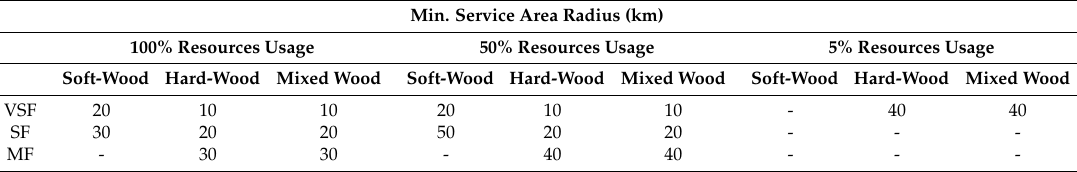
Table 7. Minimal service area radius in relation to facility size (VSF = 20 Gg year − 1 , SF = 80 Gg year − 1